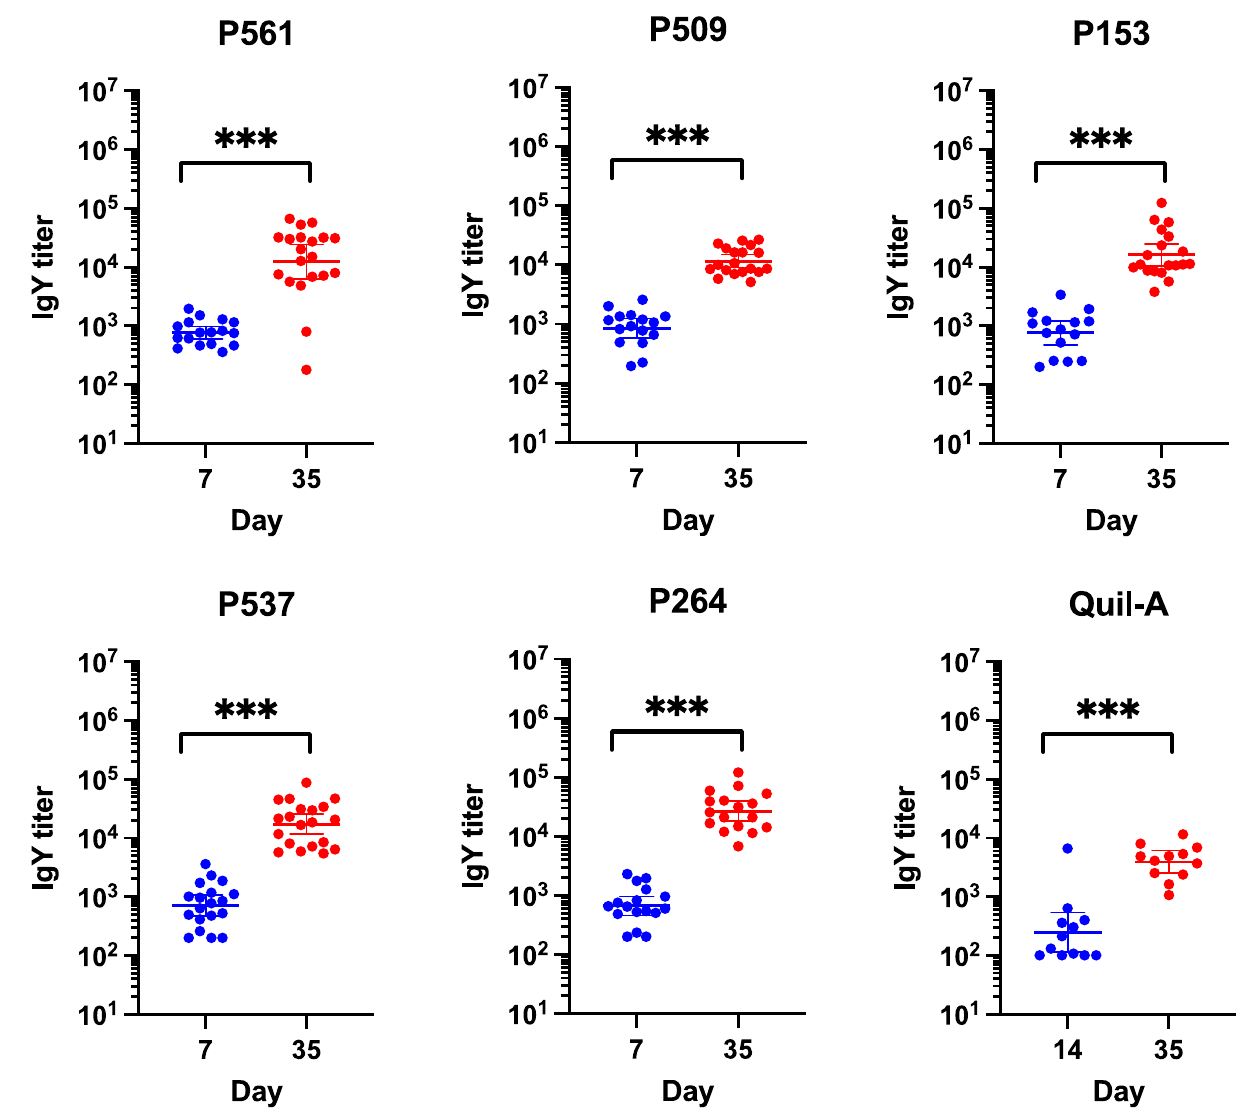
Figure 5. ELISA were performed with whole-cell lysate from C. perfringens MLG_7820 and P561, P509, P153, P264 and P537 antibodies raised in immunized birds. Quil-A response is also included. Immuno plate MaxiSorp wells were coated with 0.5 µg of whole-cell lysate from C. perfringens MLG_7820. The error bars representing standard error. The asterisks refer to the level of significance: *P ≤ 0.05; **P ≤ 0.01; ***P ≤ 0.001, determined by the Mann–Whitney test.